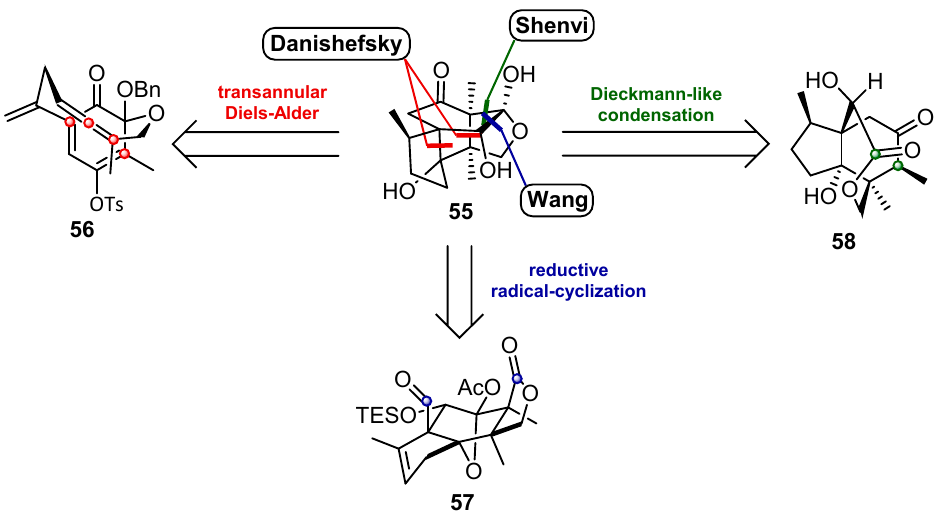
Scheme 13. Comparison of key strategies and intermediates in the construction of the tashironin backbone.